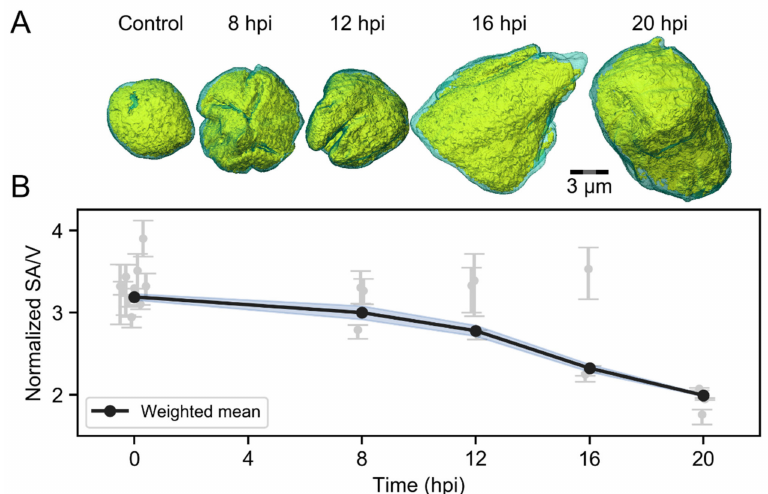
Figure 2. Infection-induced changes in the viral replication compartment (VRC) volume and chromatin smoothening. SXT analyses of non-infected ( n = 10) and infected ( n = 3) human B cells at 8, 12, 16 and 20 hpi. ( A ) Volume-rendered 3D views of nuclei showing high-density regions (condensed chromatin) in cyan and low-density regions (VRC and low-density chromatin) in yellow. Scale bar is 3 µ m. ( B ) An analysis of SXT images, showing the e ff ect of VRC enlargement on the folding of marginalized chromatin. The error-weighted averages of normalized surface area to volume ratios (SA / V) of chromatin layer around the VRC are shown. The shaded areas around the data points represent the standard error of the weighted mean